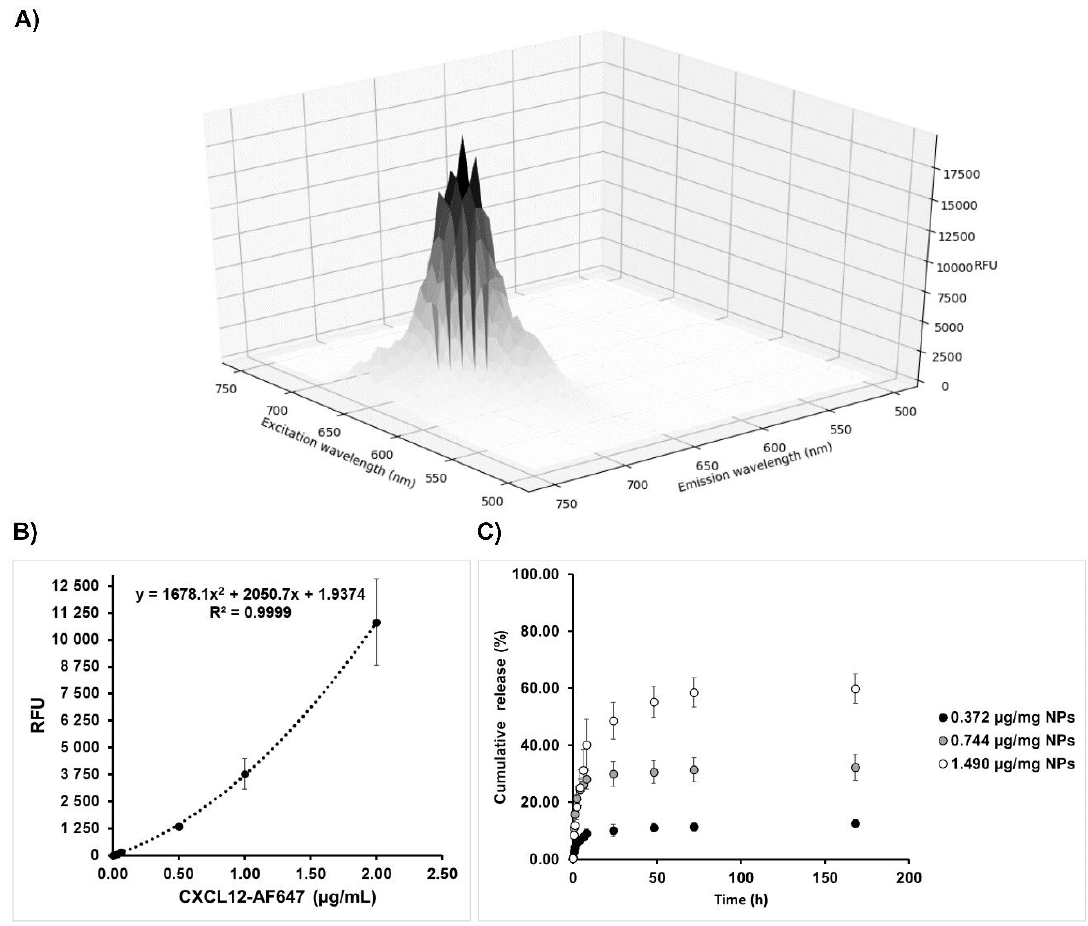
Figure 3. ( A ) 3D fluorescence scan of CXCL12-AF647 (2 µg/mL). ( B ) Standard CXCL12-AF647 curve. C ) Release kinetics ± SD of CXCL12-AF647 from Alg/Chit NPs for different mass loadings (0.372 µg/mg NPs, 0.744 µg/mg NPs, and 1.490 µg/mg NPs). Results are representative of at least three